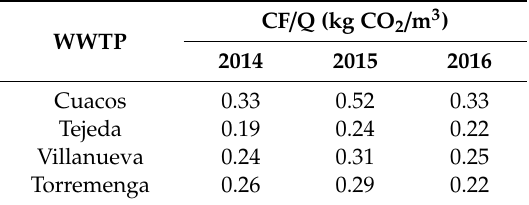
Table 5. Carbon footprint values per cubic metre of treated water.